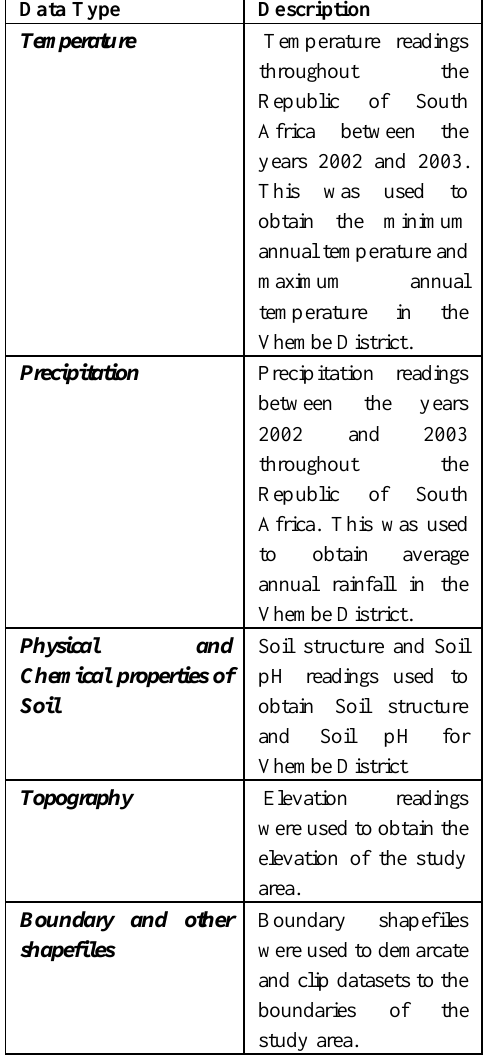
Table 1. Data Description; Source: